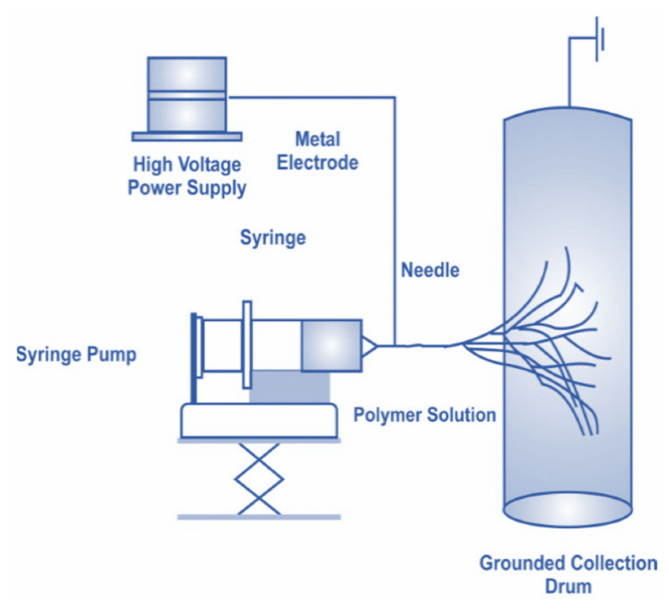
Figure 6. Electrospinning process with rotating mandrel